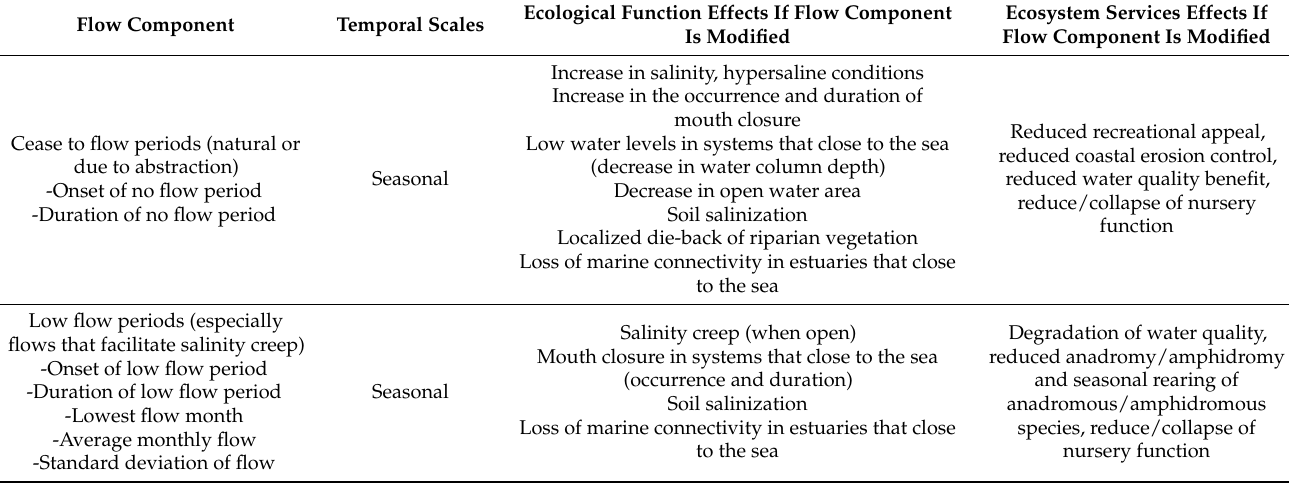
Table 1. Flow components characterizing the hydrological profile and associated ecological functions and ecosystem services of estuaries based on